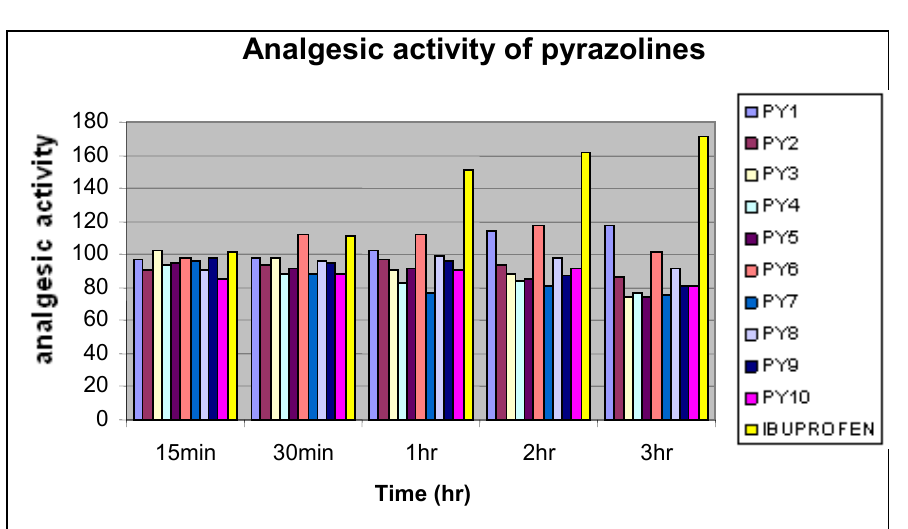
Figure 1. Analgesic activity of 2-pyrazolines 4